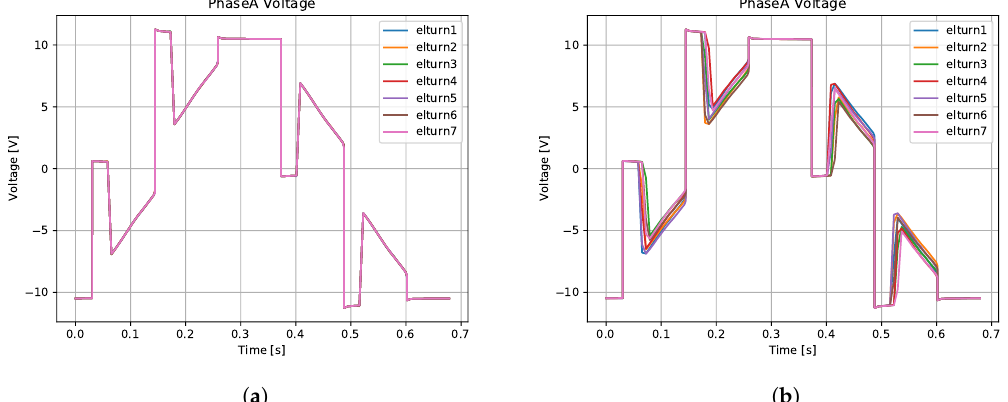
Figure 9. Comparison of the Phase A Voltages of the healthy and damaged motor—12,500 RPM. ( a ) Phase A Voltage—Healthy; ( b ) Phase A Voltage—Damaged.